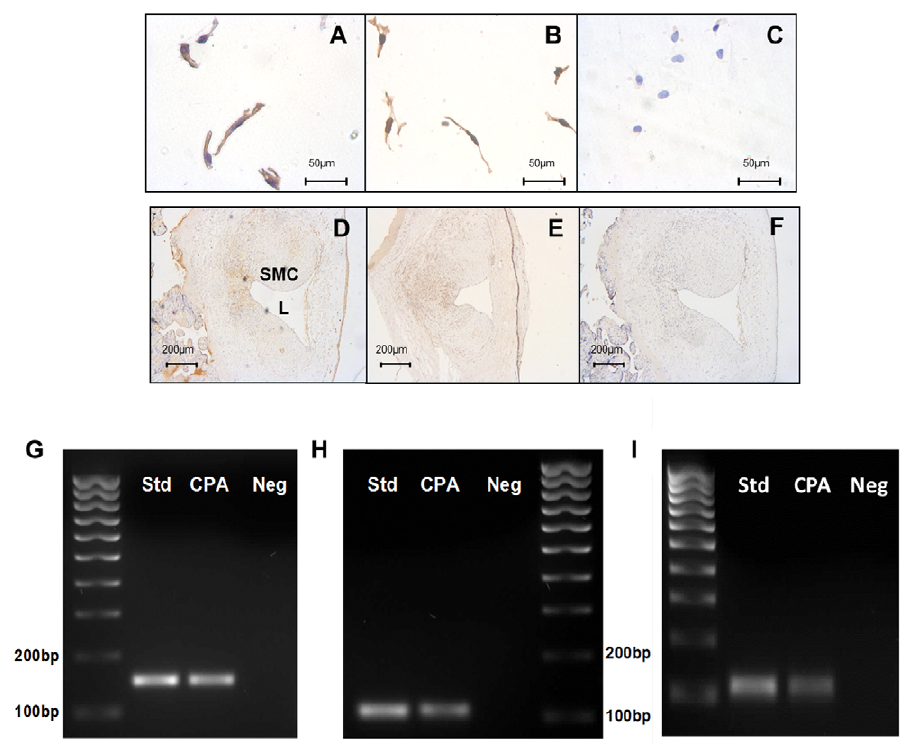
Figure 7. mRNA and protein expression of K Ca channels in CPAs. Isolated CPASMCs expressed BK Ca ( A ) and IK Ca ( B ) protein. BK Ca ( D ) and IK Ca ( E ) protein was localised to the SMCs in intact CPA sections. Negative control ( C ) and ( F ); substitution of primary antibody with non-immune IgG. RT- PCR detection of BK Ca ( G ) IK Ca ( H ) and SK Ca 3 ( I ) transcripts in human reference cDNA (Std), chorionic plate artery (CPA). Negative (Neg) is omission of cDNA. Amplicon lengths; BK Ca 147, IK Ca 102 and SK Ca 3 106. SMC; smooth muscle cell, L; lumen.